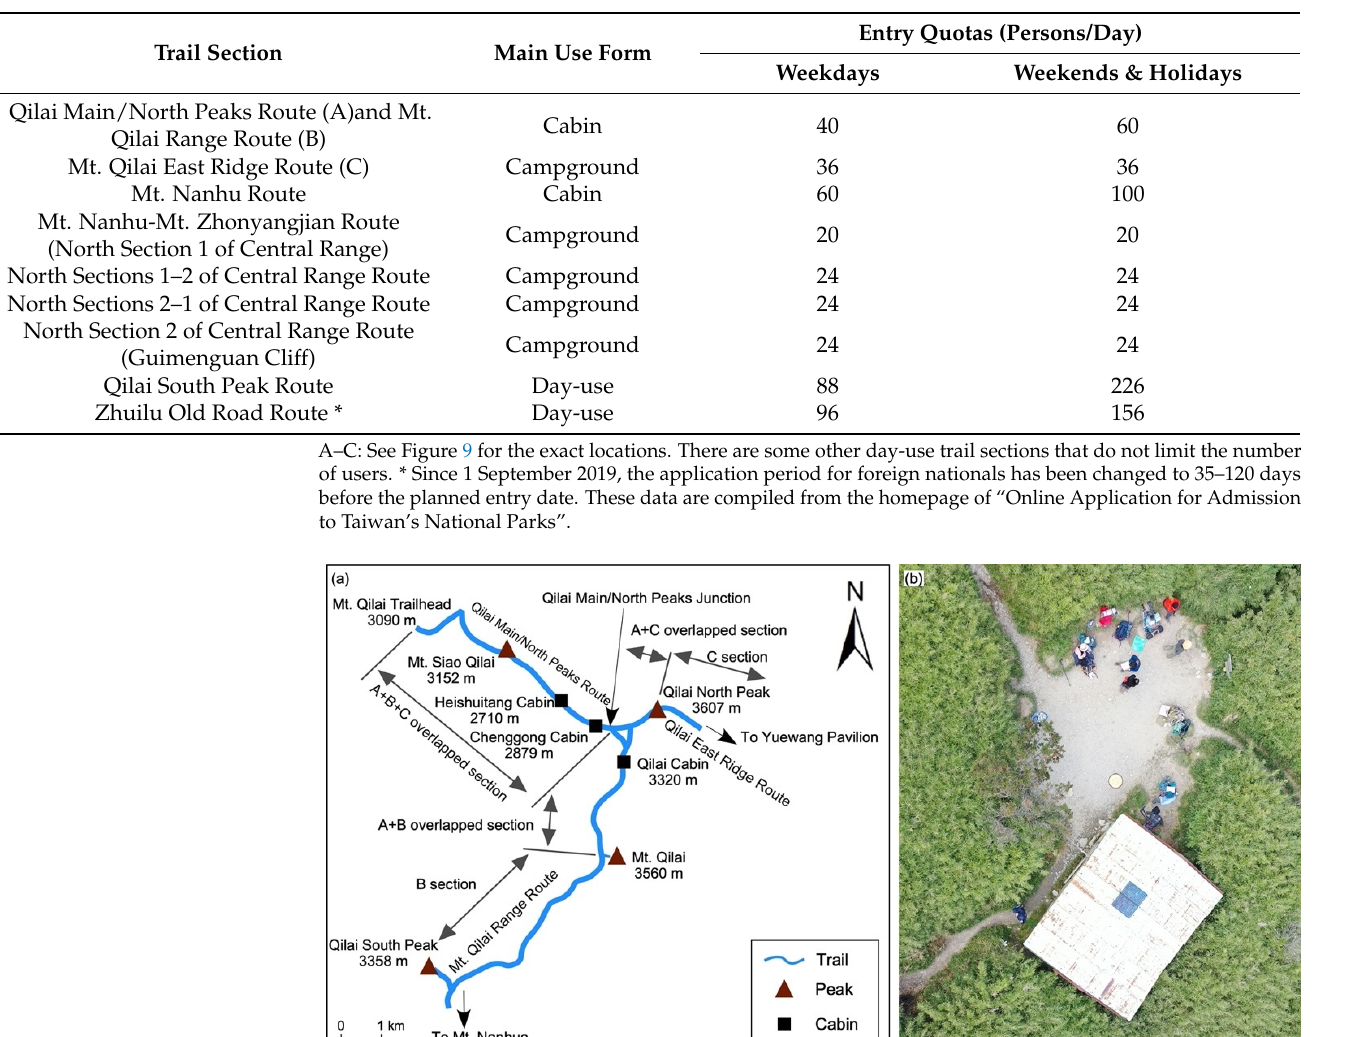
Table 3. The limits on the number of users on each main trail section in Taroko National Park.